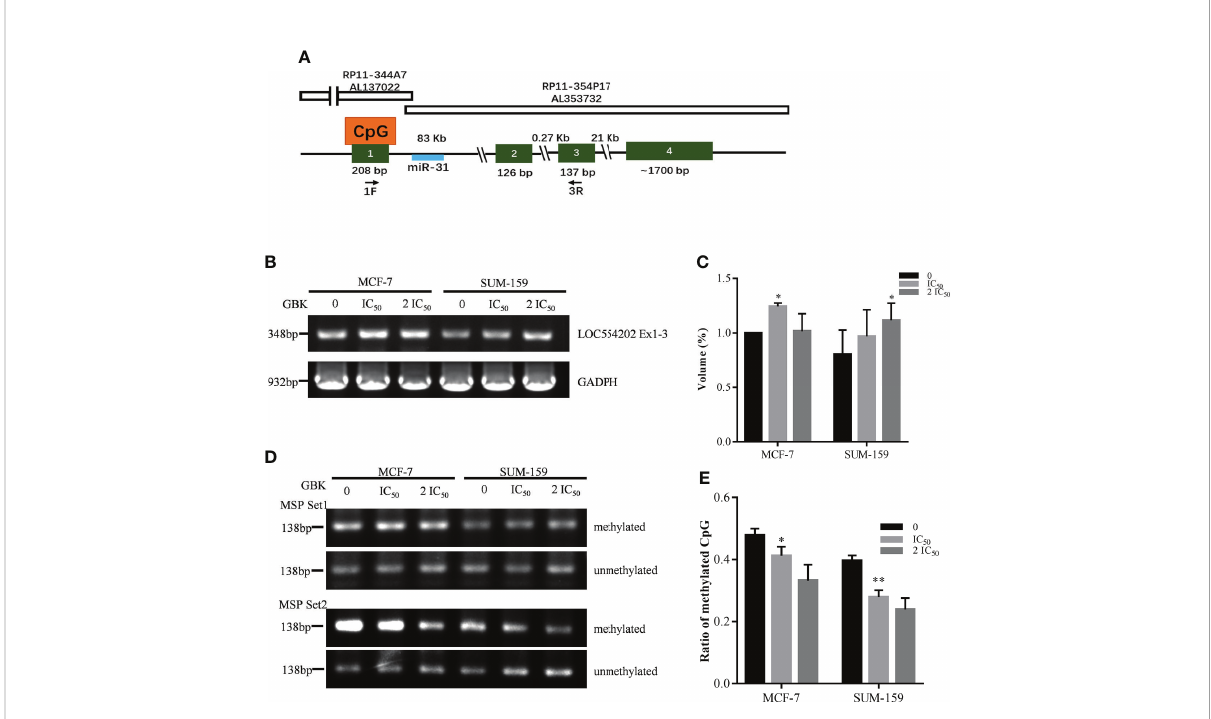
FIGURE 4 Gene expression and promoter hypermethylation of LOC554202 are modi fi ed after GBK treatment in MCF-7 and SUM-159 cells. (A) Schematic representation of genomic organization of LOC554202 gene [adapted from (27)]. (B) Semi-quantitative RT-PCR of LOC554202 transcript in MCF-7 and SUM-159 cells. GAPDH was used as an internal control. Quantitative analysis of the data was shown in (C) . (D) Hypermethylation of two CpG sites in LOC554202 promoter was detected by Methylation speci fi c PCR (MSP) in MCF-7 and SUM-159 cells. Bisul fi te-modi fi ed DNA extracted from the indicated samples was detected using 2 sets of primers. (E) Methylation ratios for all CpGs (including methylated and unmethylated) obtained by sequencing the bisul fi te-modi fi ed DNA using Set2 primers. Data are presented as mean ± s.e.m. of three independent experiments. Student ’ s t test, *p < 0.05, **p <